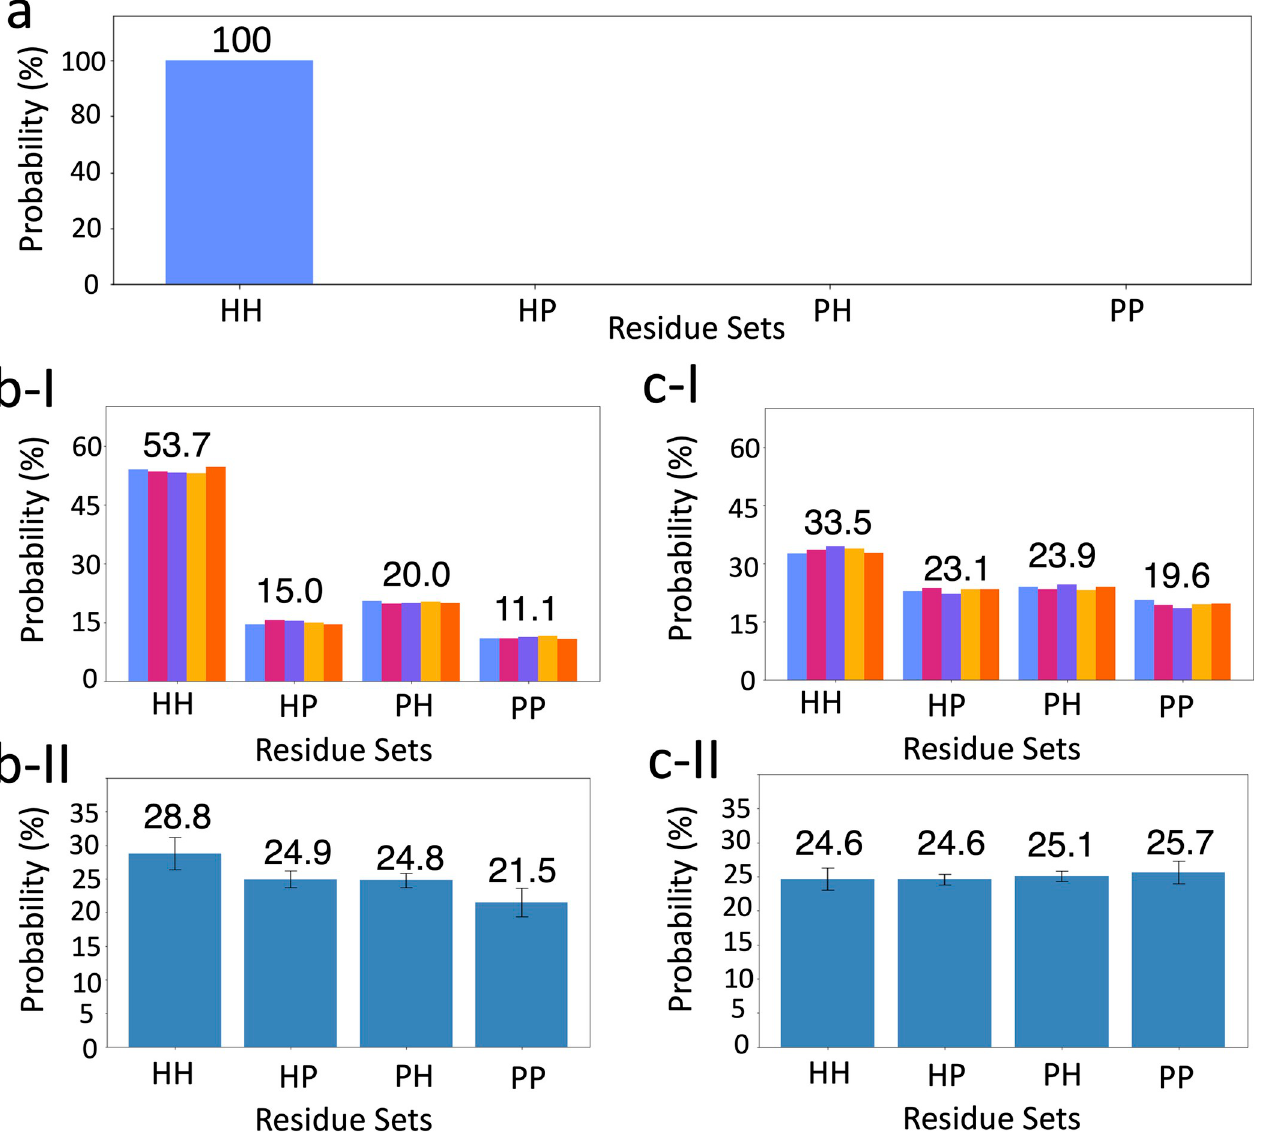
Fig 7. Histogram representations of probabilities for each state in the IBM-SP model circuit. a) Results of the circuit, using the ideal MPS quantum computer simulator. b) Results of the circuit using: I) gate fidelity, measurement fidelity, initialization fidelity and qubit mapping of ibmq_toronto in the simulator; II) Real ibm_toronto device averaged over 20 different runs. c) Results of the circuit using: I) gate fidelity, measurement fidelity, initialization fidelity and qubit mapping of ibmq_montreal in the simulator; II) Real ibm_montreal device averaged over 30 different runs. In b) and c), the data bars with different colours show results for five separate runs. The error bars represent the standard deviation from the mean value. The numbers on each set of bars show the average probability of the state. The number of samplings for all plots is set to 8,192 shots.